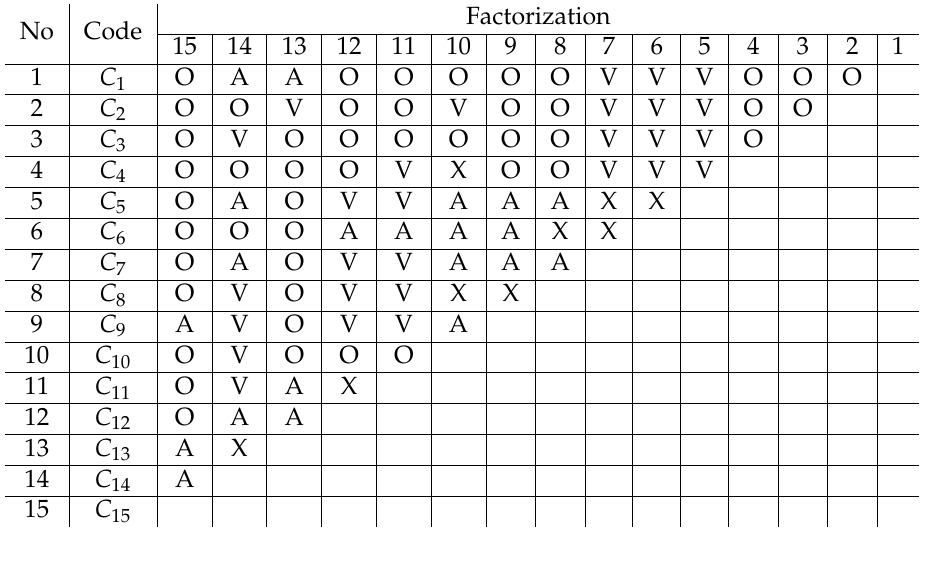
Table 5. Results of the structural self interaction matrix (SSIM)